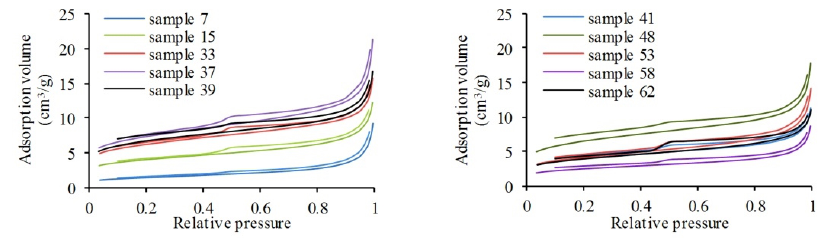
Figure 4. Nitrogen adsorption–desorption isotherms.